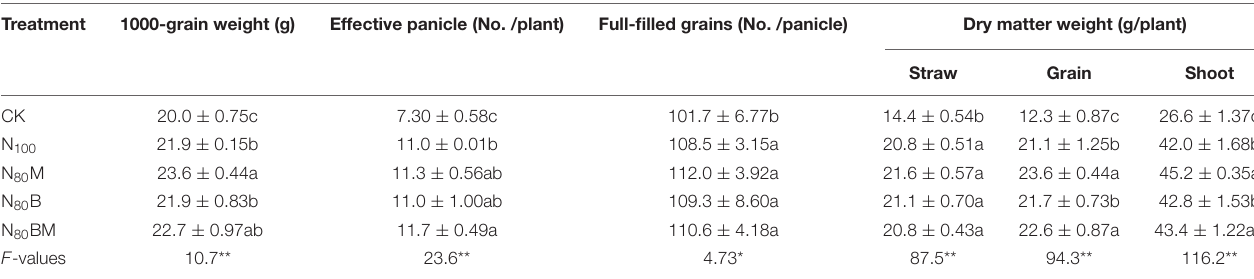
TABLE 2 | Effects of applying rice straw biochar and/or leguminous cover crop residue on dry matter weight and yield components of rice